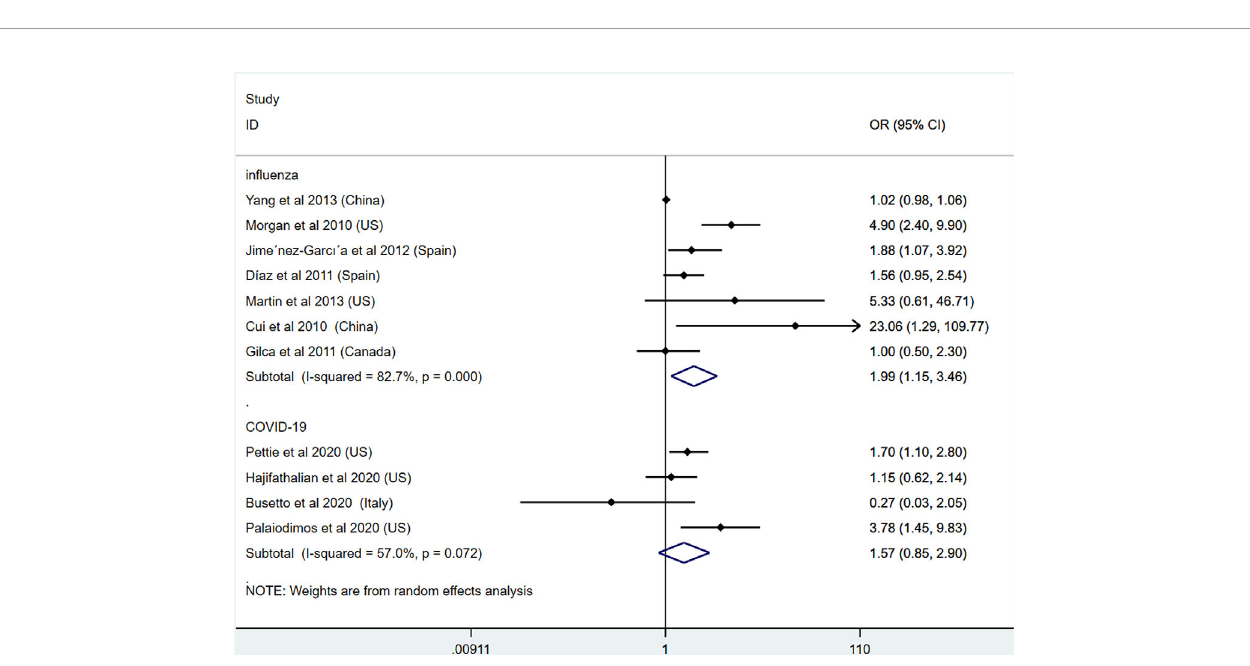
FIGURE 6 | Odds ratios for the mortality of patients with obesity and in fl uenza or